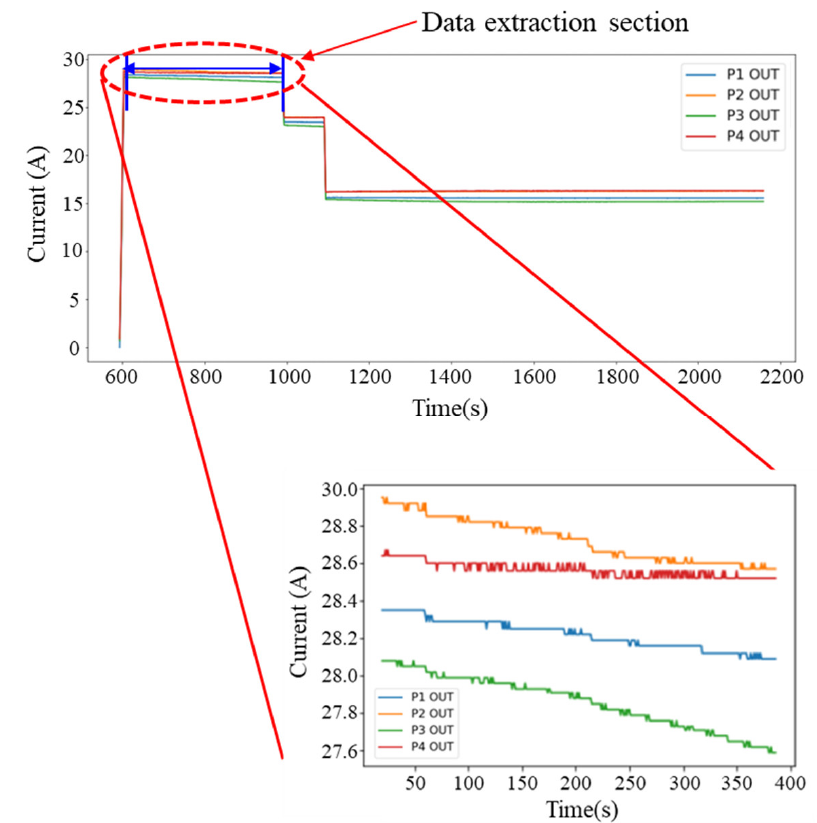
Figure 7. Fast-charger output current (DC) data extraction.